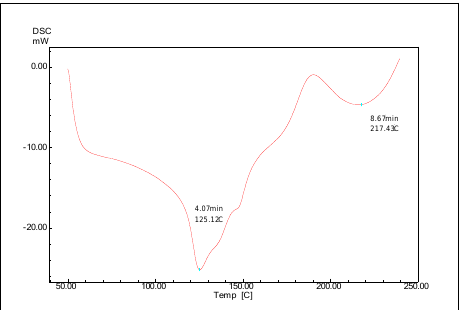
Figure 6: DSC curve of cefixime trihydrate.